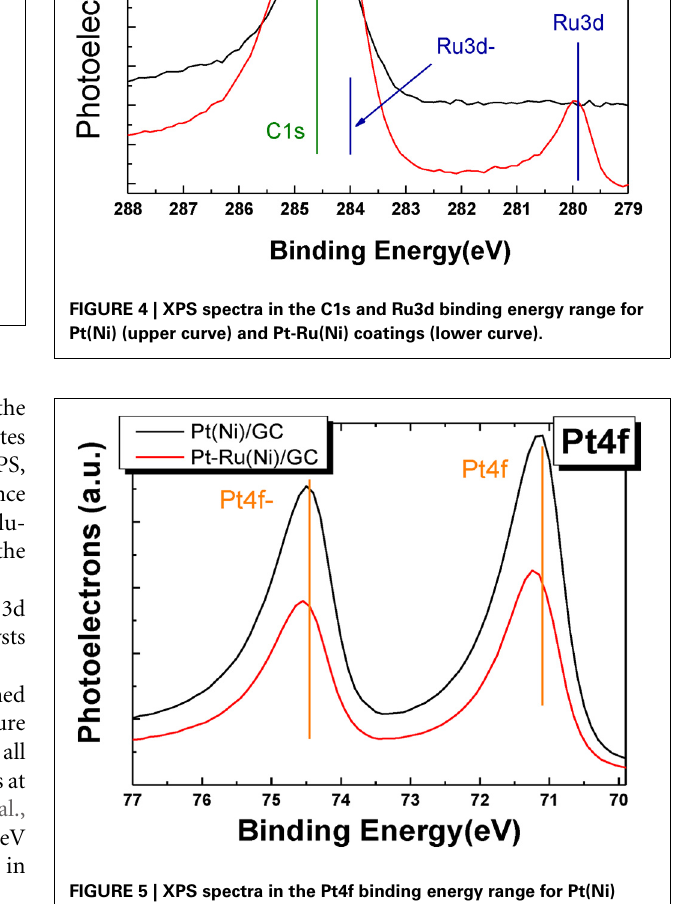
FIGURE 5 | XPS spectra in the Pt4f binding energy range for Pt(Ni) (upper curve) and Pt-Ru(Ni) (lower curve)